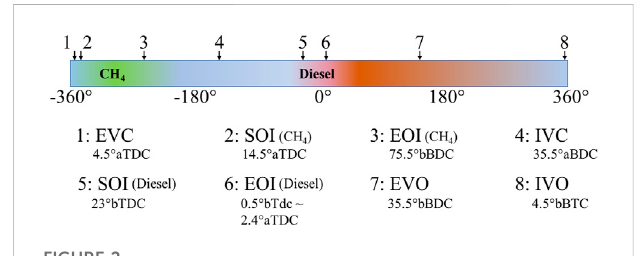
FIGURE 2 Valve timing and fuel injection diagram for the test setup.